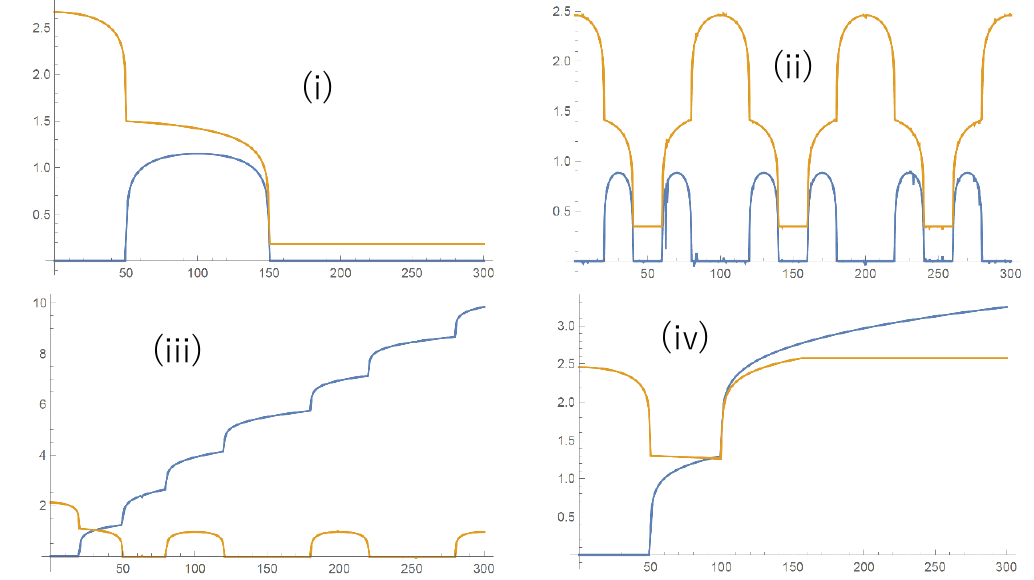
Figure 38 . The time evolution of HEE in BTZ BH phase. The horizontal axis is for the time t , and the vertical axis is for (cid:1) S A . We set b = 50 and a = 0 : 05 (corresponding to s = 5 : 28 : : : ( > 1)), and the subsystem A is chosen to be (i), (ii), (iii) and (iv). The upper left graph is for (i), the upper right is for (ii), the lower left is for (iii), and the lower right is for (iv). Blue and orange curves describe the HEE for connected and disconnected geodesics,